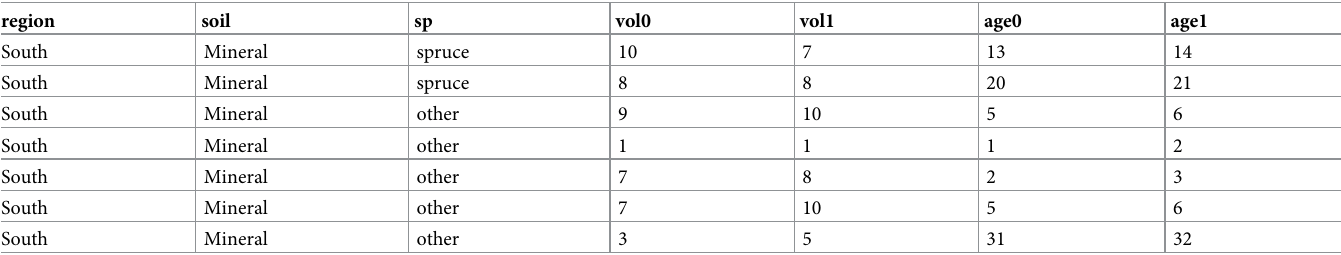
Table 2. A subset of the pair data in the example dataset: The stratifying variables region, soil, dominant tree species (sp) are accompanied by observed change in dynamic variables vol and age, where index ‘0’ refers to the first and ‘1’ to the second measurement of the sample plot. region soil sp vol0